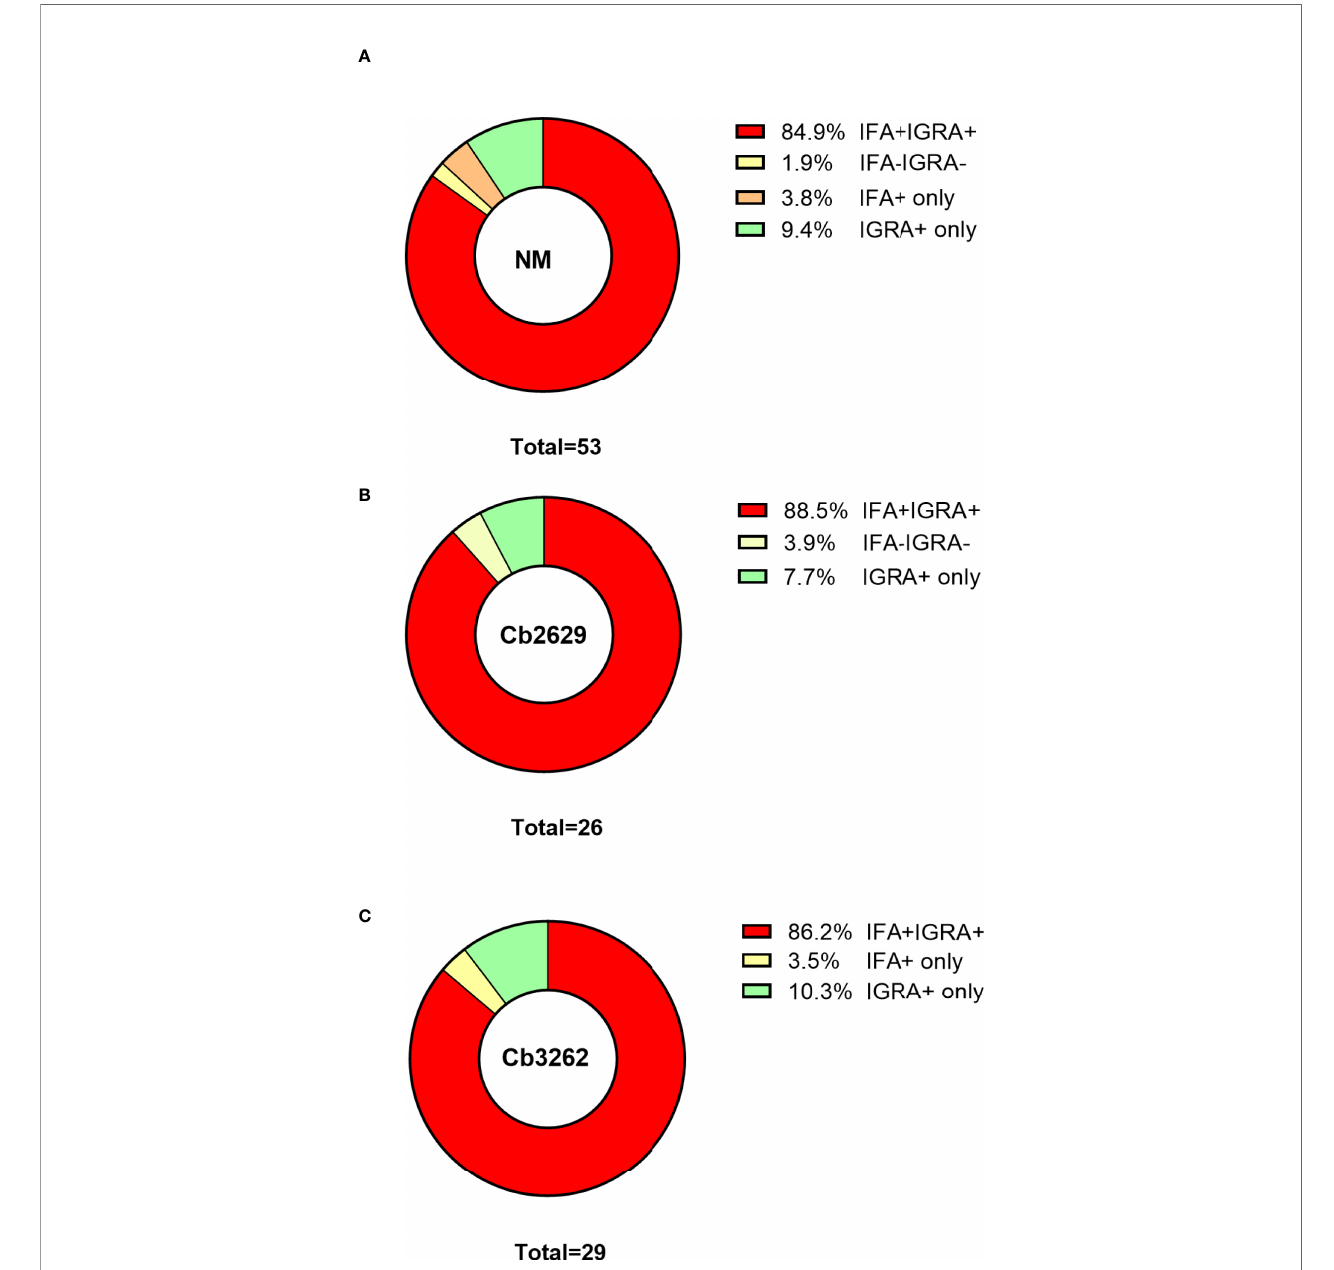
FIGURE 5 | IGRA and IFA results in individuals with noti fi ed Q fever. The proportion of individuals that scored positive or negative by IFA and IGRA results [shown separately for (A) Nine Mile, (B) Cb2629 and (C) Cb3262] was analyzed for individuals who were reported to the Municipal Health Service with Q fever between 2007 and